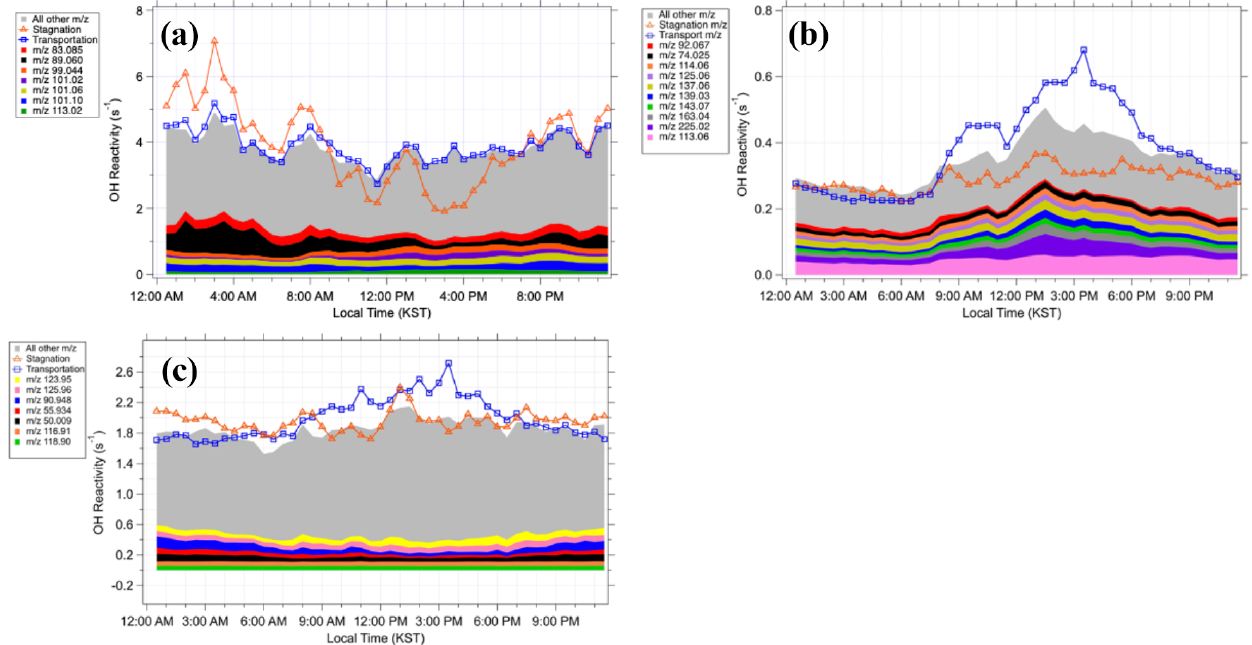
Figure 6. Diurnal averages of the OH reactivity from the compounds in (a) Category I, (b) Category II, and (c) Category III.